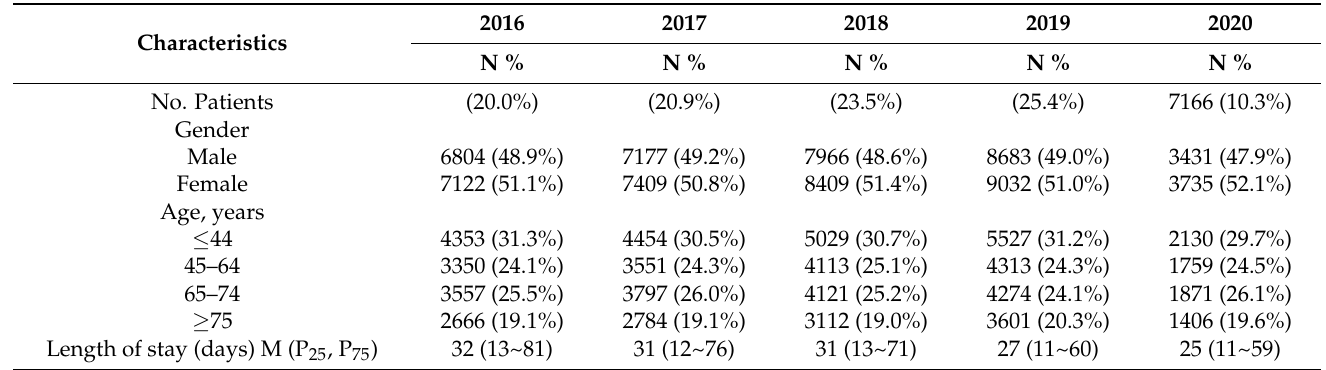
Table 1. Characteristics of patients who visited the mental health inpatient service between 2016 to